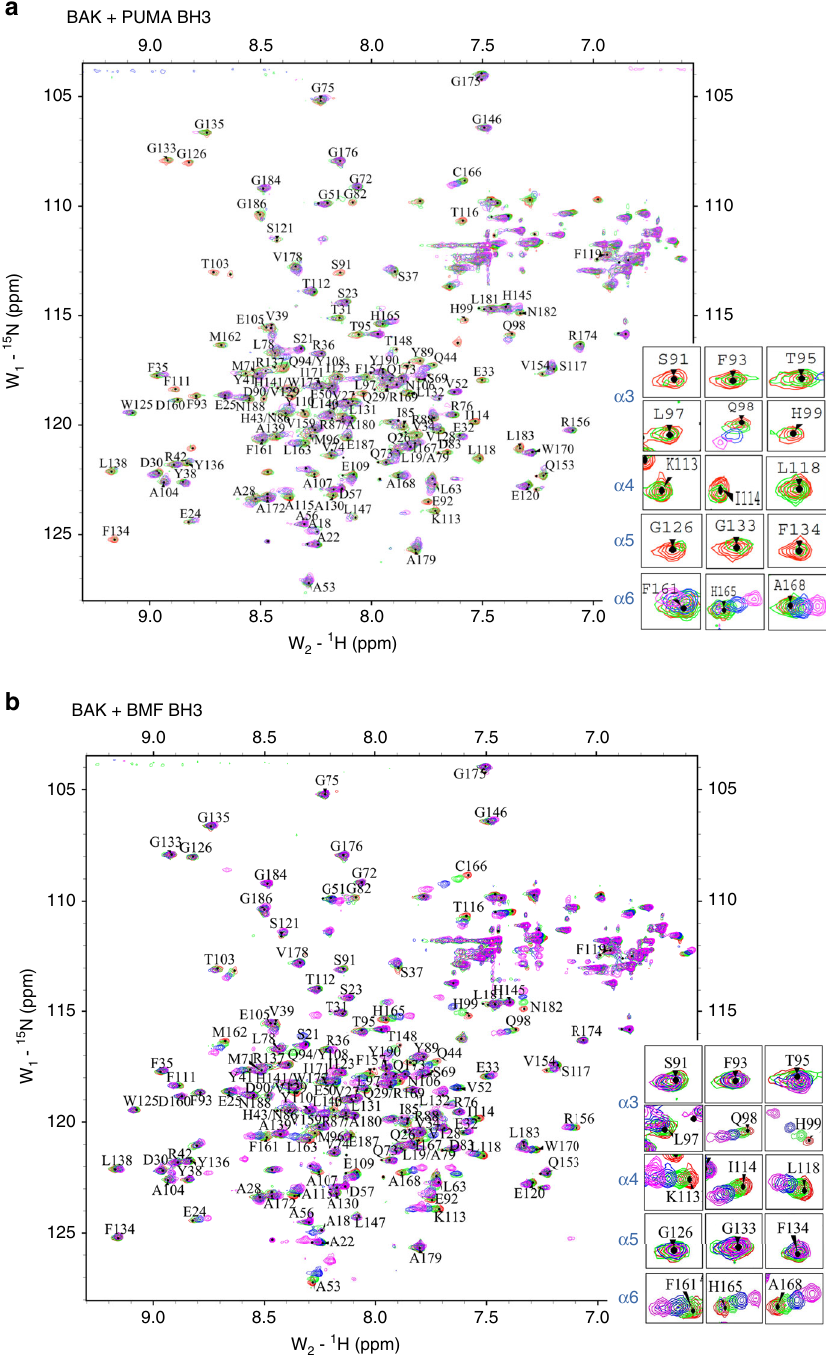
Fig. 4 1 H, 15 N-HSQCs of BAK 15 – 186 indicate different residues perturbed by BMF and PUMA BH3. a , b 1 H, 15 N-HSQC spectra of 0.5 mM 15 N-labeled BAK 15 – 186 perturbed by different concentration ratios of PUMA BH3 peptide a or BMF BH3 peptide b shown in different colors. Protein:peptide ratios were as follows: Red, no peptides; green, 1:1; blue, 1:2; and purple, 1:4. Peaks on the right indicate the perturbations at selected